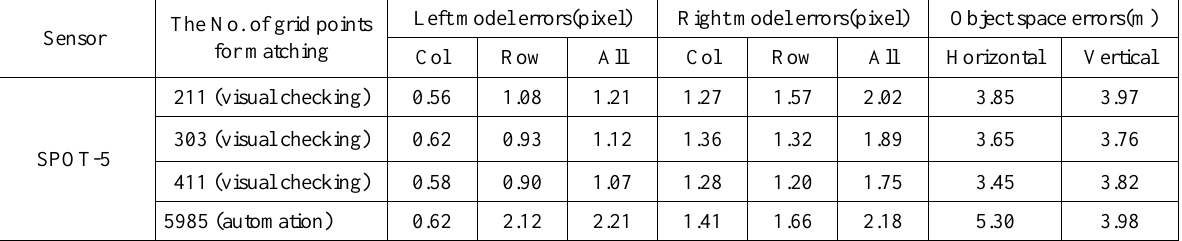
Table 2. Accuracy of the absolute models from DEM matching with different number of grid points